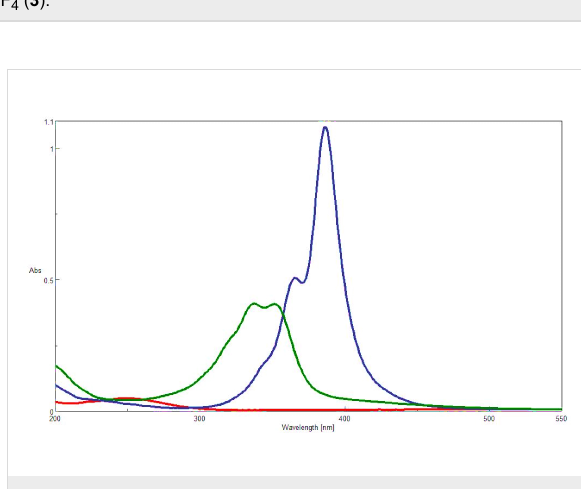
Figure 3: UV–vis spectra of 2 (red line), 3 (blue line) and 5 (green line).